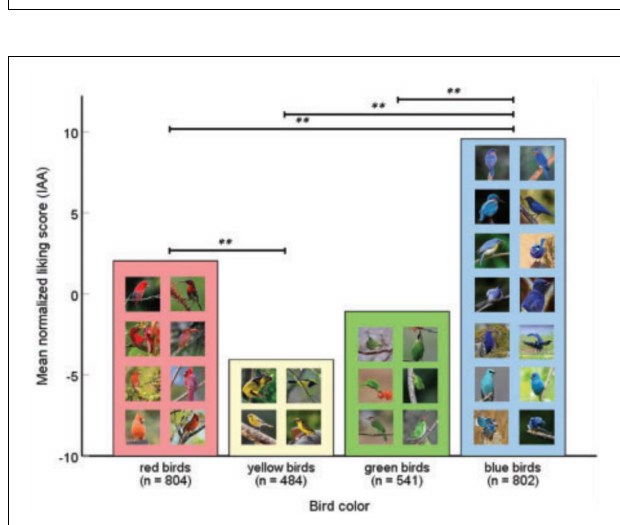
FIGURE 5 | Human bird color preferences ( η 2 = 0.028). **The mean difference is significant at the 0.01 level. Adapted from Thömmes and Hayn-Leichsenring